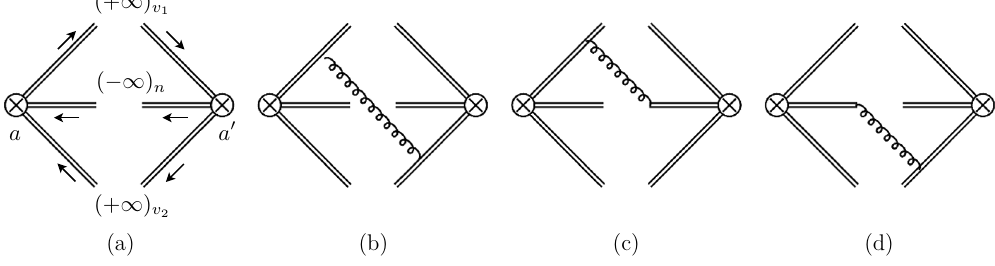
Figure 4 . Tree level soft function is shown in diagram (a). Each double line represents a Wilson line whose pointing direction is also reported as ( ) u , u = n; v; (cid:22) v ; a and a 0 are color indices. (cid:6)1 Diagrams (b), (c) and (d) also contribute to the NLO soft function. Virtual contributions vanish and therefore they are not shown here. Mirror diagrams are also not